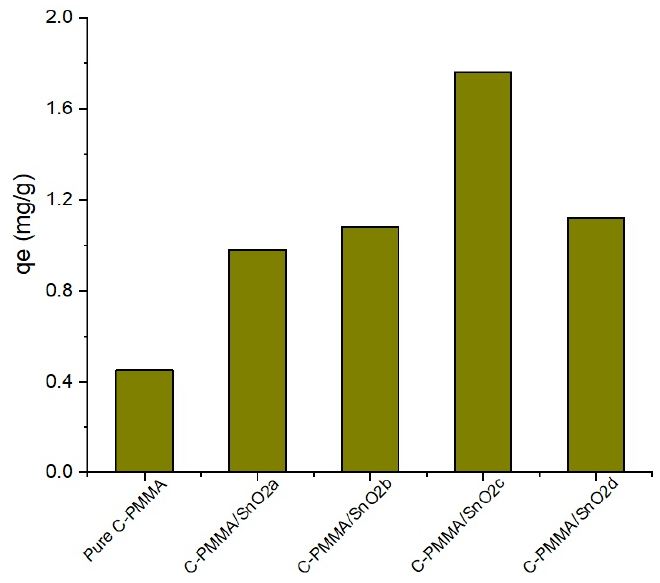
Figure 5. Surface selectivity study of pure C-PMMA and C-PMMA/SnO 2(a–d) for Cr (III).